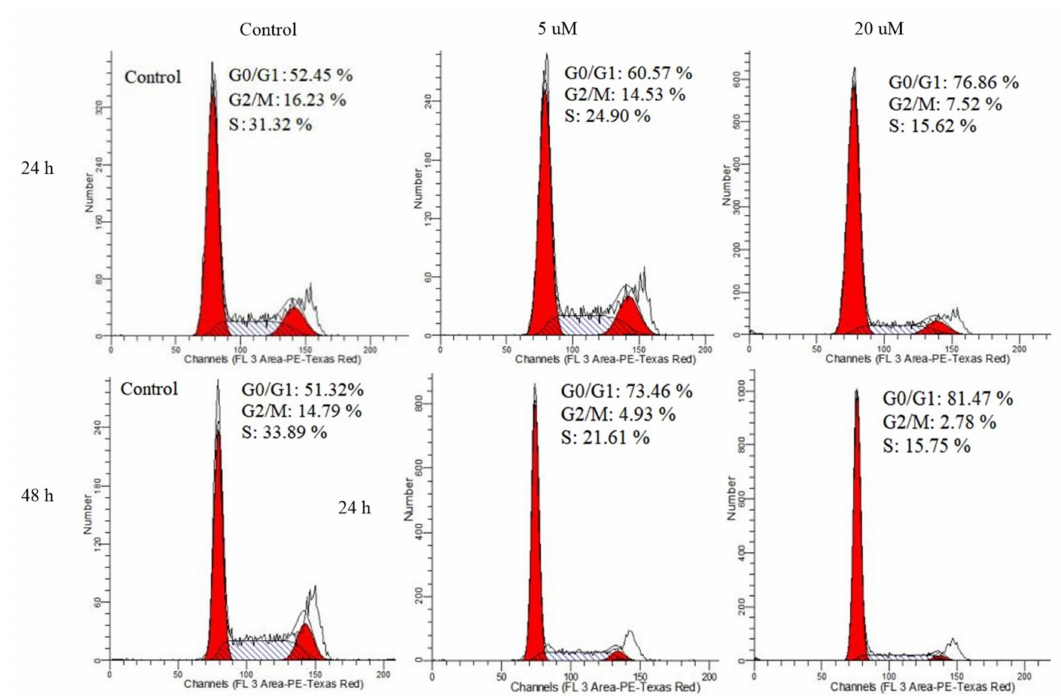
Figure 11. HepG2 cell cycle distributions after exposure to 5 µ M and 20 µ M complex 2 for 24 h and 48